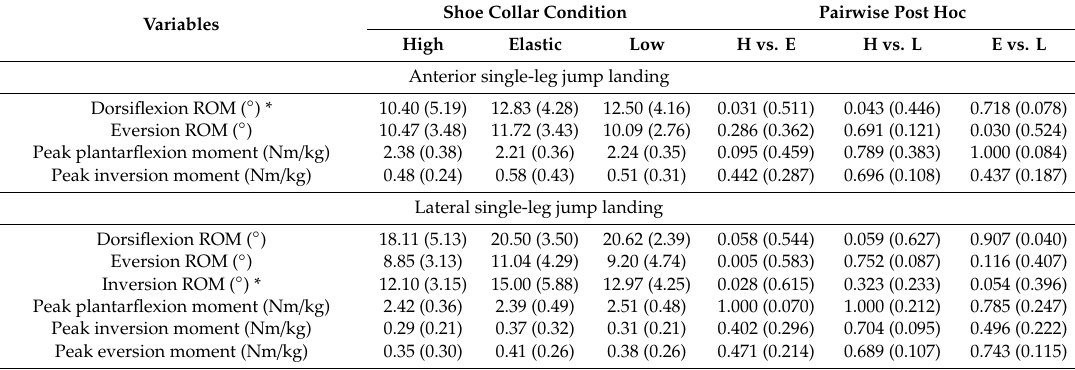
Table 1. Mean (standard deviation) of biomechanical variables and pairwise post hoc p -value (Cohen’s dz) in ankle joint during tasks in the high-, elastic-, and low collar shoe